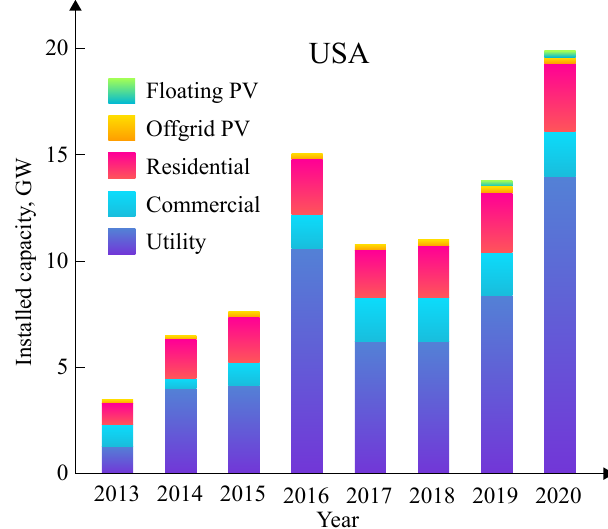
Figure 11. U.S. installed capacity of different solar applications. The utility-scale solar applications have the largest penetration, followed by residential and commercial deployments